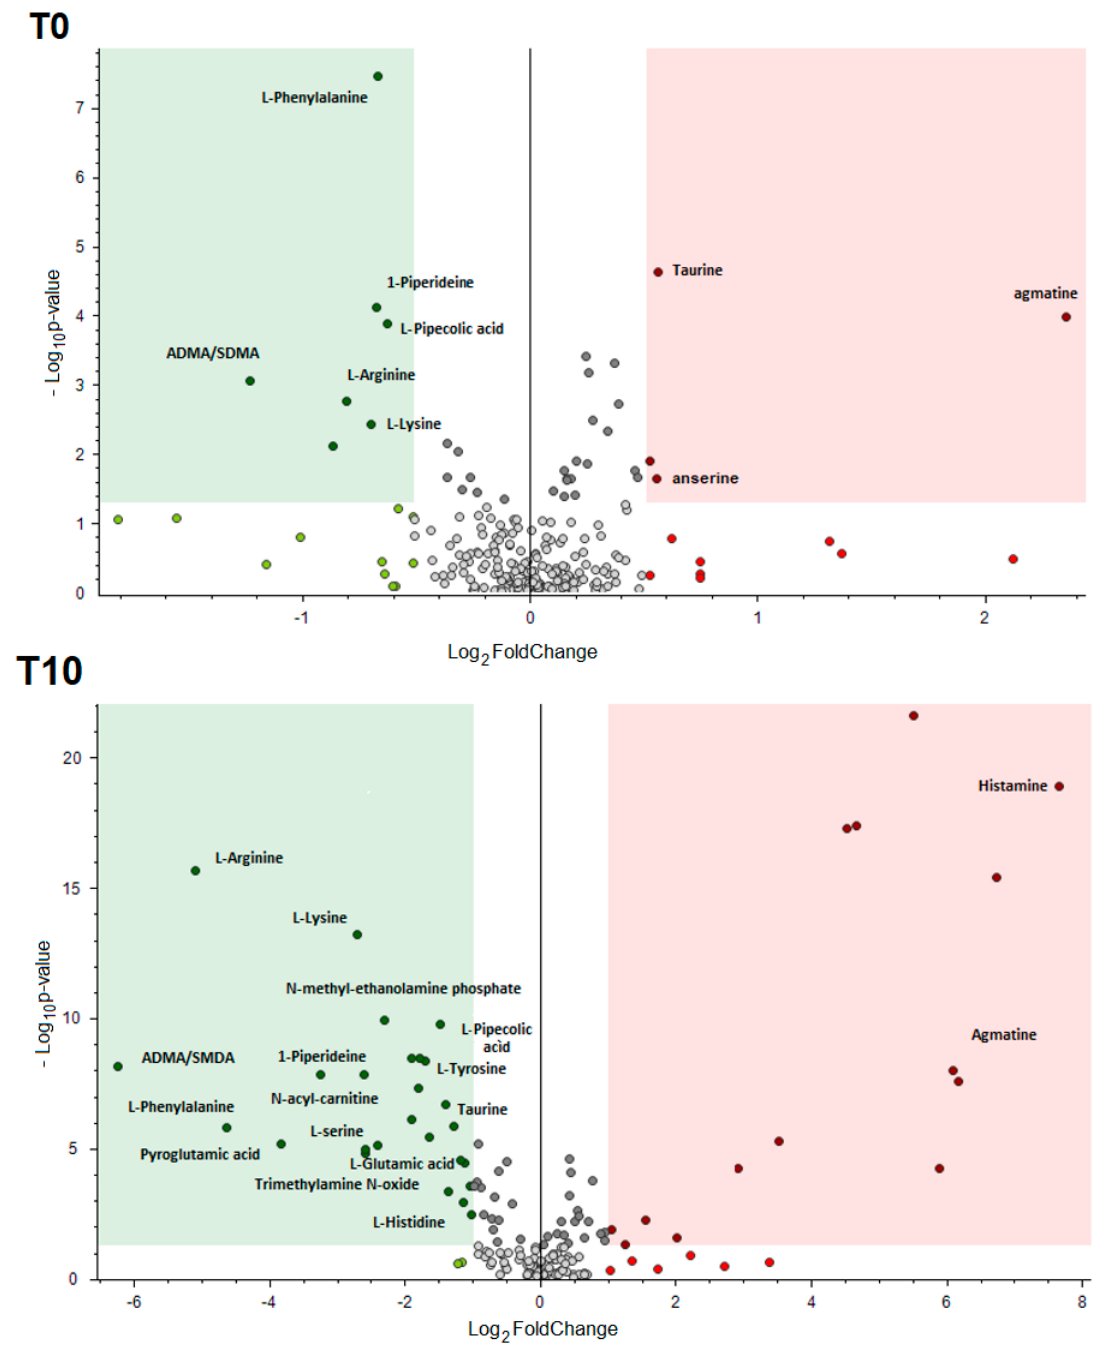
Figure 2. Volcano plot comparison between the relative intensity of chromatographic peak from fresh and pulled frozen / thawed salmon samples. The green region contains up-regulated signals with intensities from fresh samples significantly lower than those from pulled frozen / thawed and were greater than the upper fold-change (FC) threshold. The red region includes down-regulated peaks where the intensities from fresh were significantly higher than those from pulled frozen / thawed and was less than the lower FC threshold. p -value (PV) = 0.05.